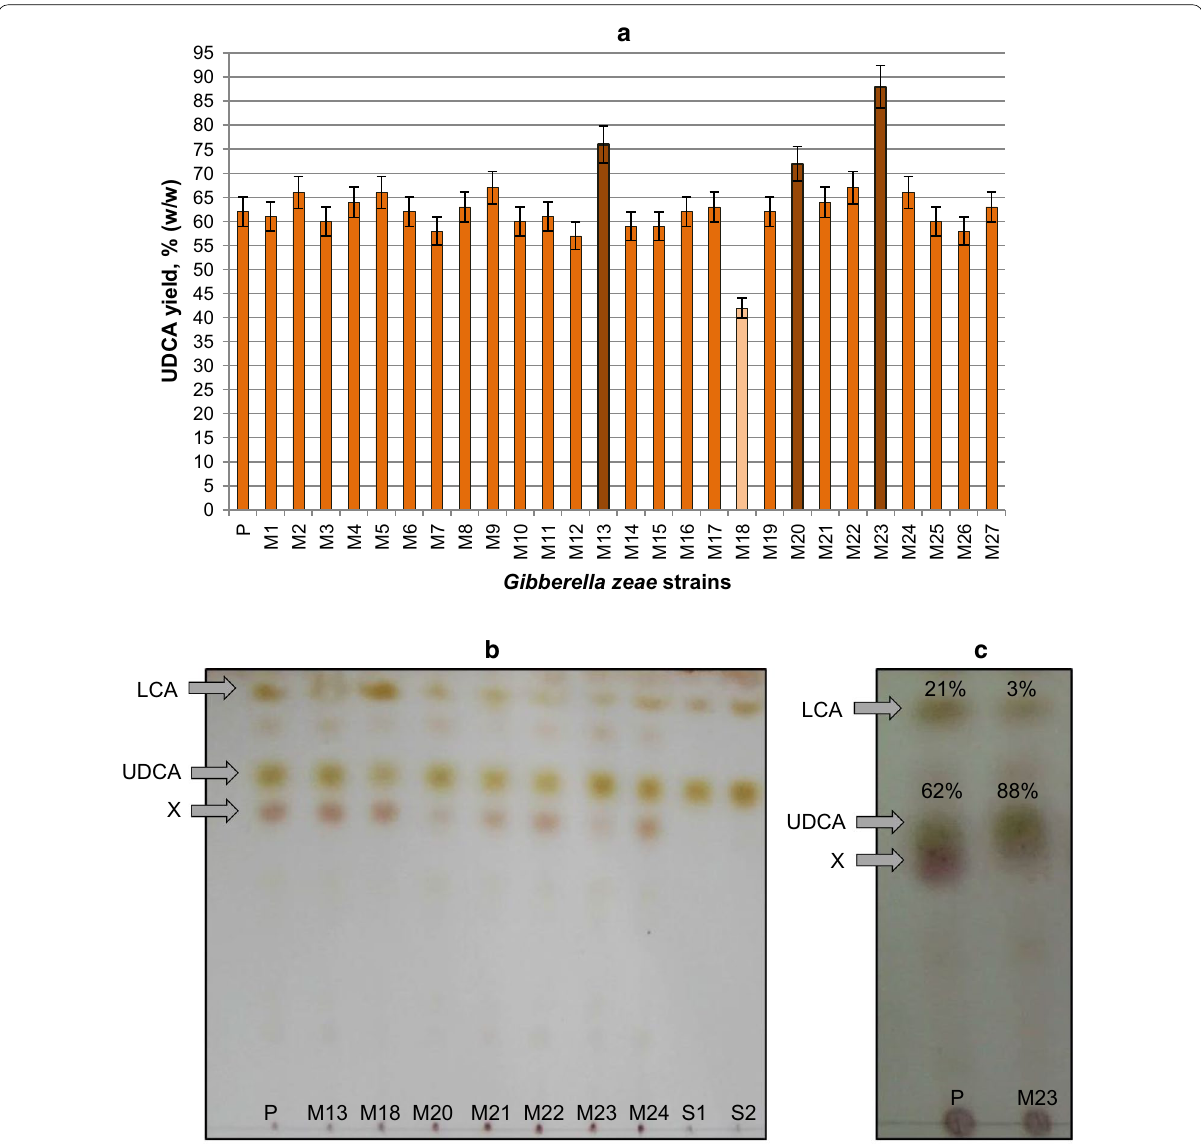
Fig. 8 Comparative statistical analysis of LCA to UDCA conversion (144 h) by G. zeae parent (P) and mutant (M) strains (GC data of three independent experiments) ( a ). TLC profiles of 120 h ( b ) and 144 h ( c ) samples (~ 10 µg of steroids in the spot): S1, standard samples of LCA (0.5 mkg) and UDCA (7 mkg); S2, standard samples of LCA (1.0 mkg) and UDCA (8 mkg) (top to bottom); X–undefined metabolite (the structure of the product was not determined due to its low amount and concomitant formation of several metabolites). LCA initial concentration was 4